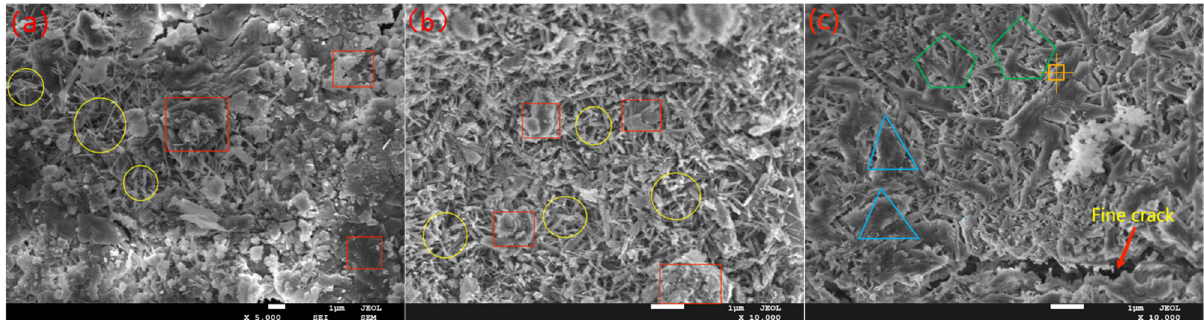
Figure 9: Morphology of hydration products of GOPARMs with di ff erent PA dosage ( yellow circles: AFt; red rectangles: other amorphous hydration products; green pentagon: AFt wrapped in PA; blue triangles: agglomerates composed of hydration products and PA ) : ( a ) without PA dosage; ( b ) PA dosage 5 wt%; ( c ) PA dosage 10 wt%.